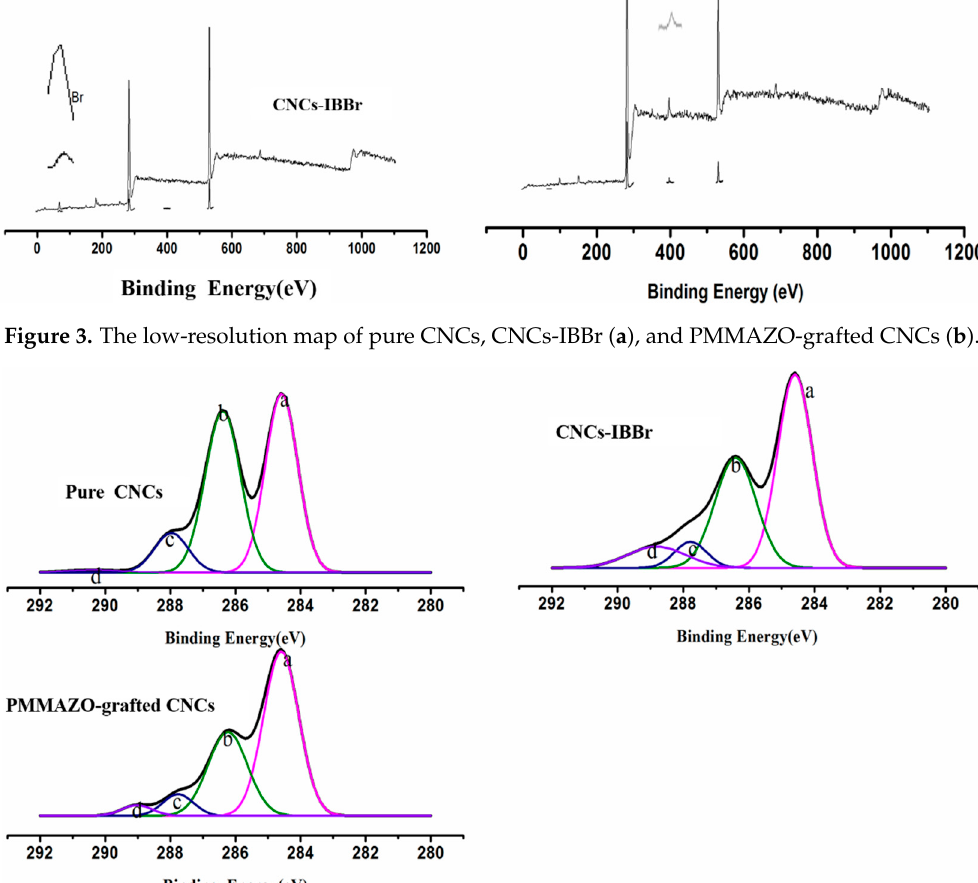
Figure 4. The high-resolution C1s spectra of pure CNCs, CNCs-IBBr and PMMAZO-grafted CNCs.